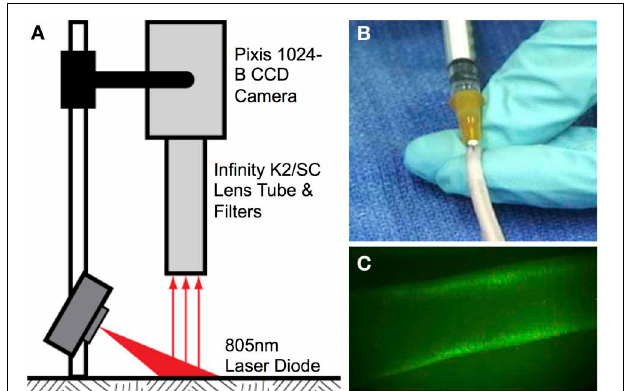
FIGURE 1 | Near-infrared lymphatic imaging setup. (A) Schematic of near-infrared imaging hardware. (B) Intradermal tail injection of near-infrared fluorophore. (C) Example of imaging window 10cm proximal to injection site showing fluorescence uptake in the two collecting lymphatic